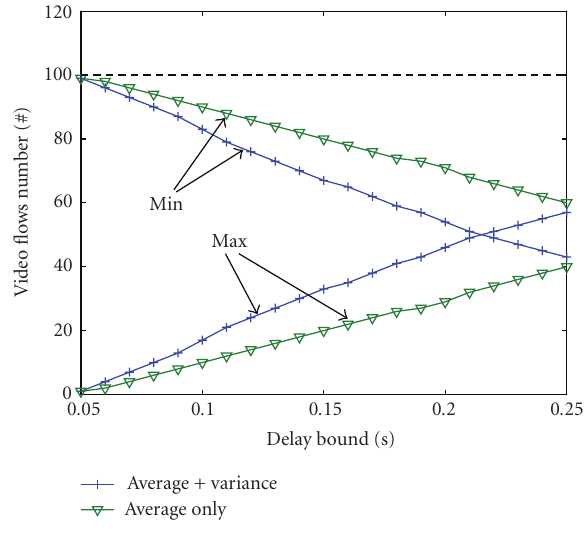
Figure 6: The number of flows admitted at Ω max and Ω min using di ff erent resource allocation